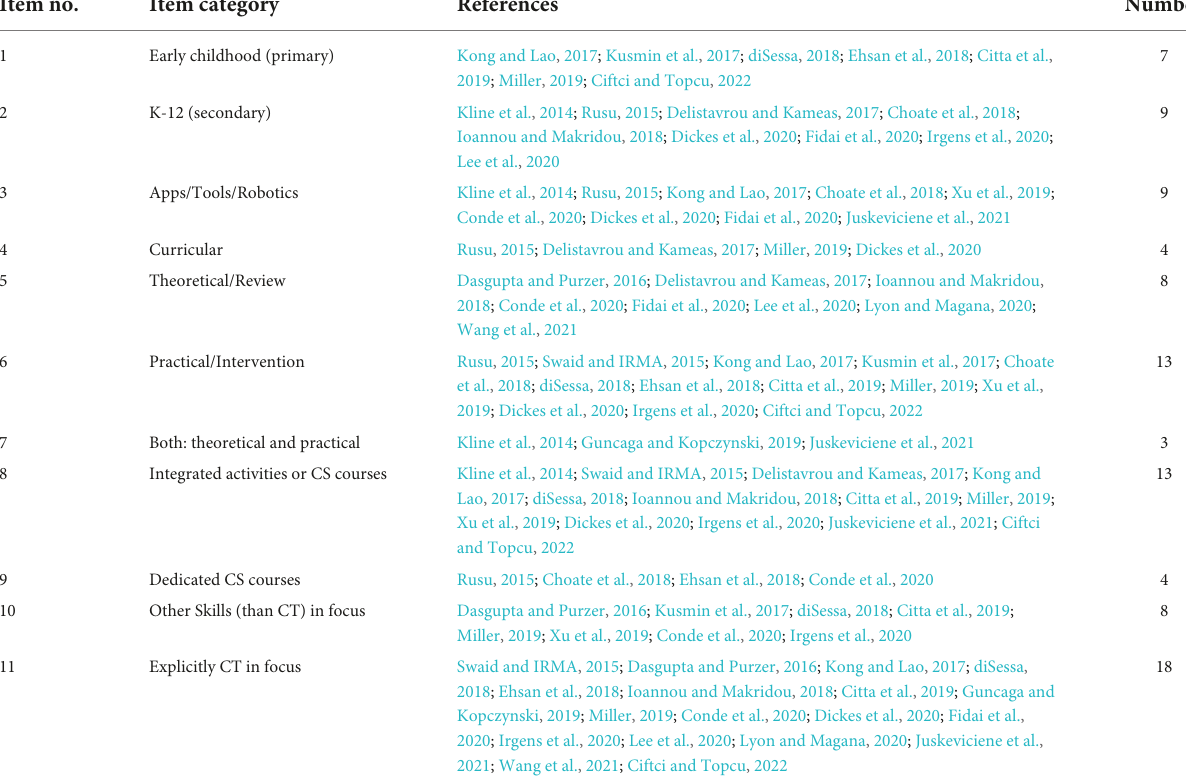
TABLE 3 Number of papers by item